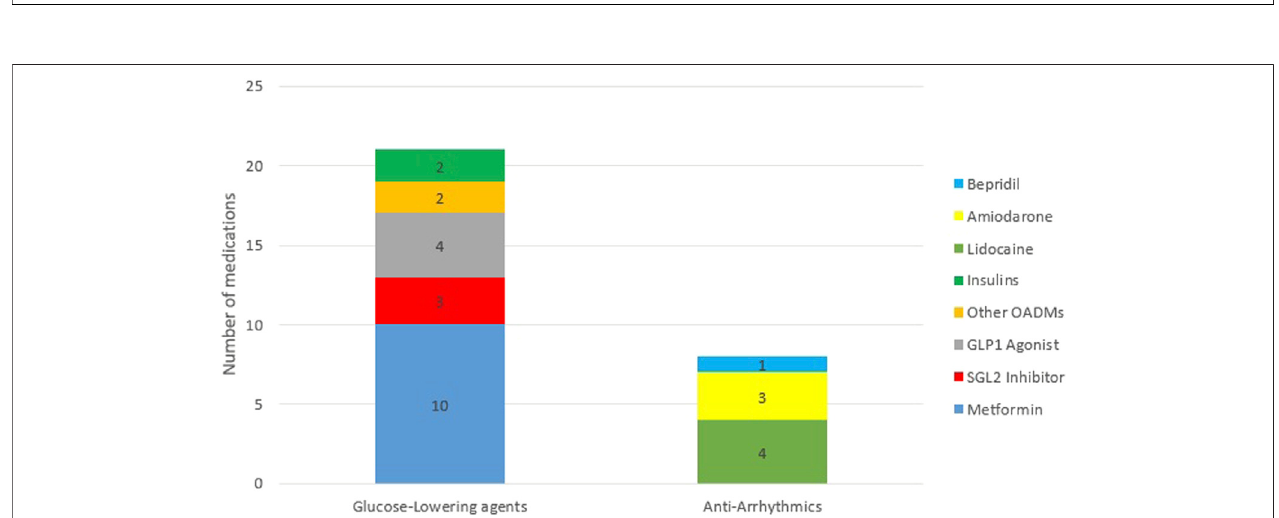
FIGURE 2 | Decade of trend in the number of observational studies with PK/PD modeling.